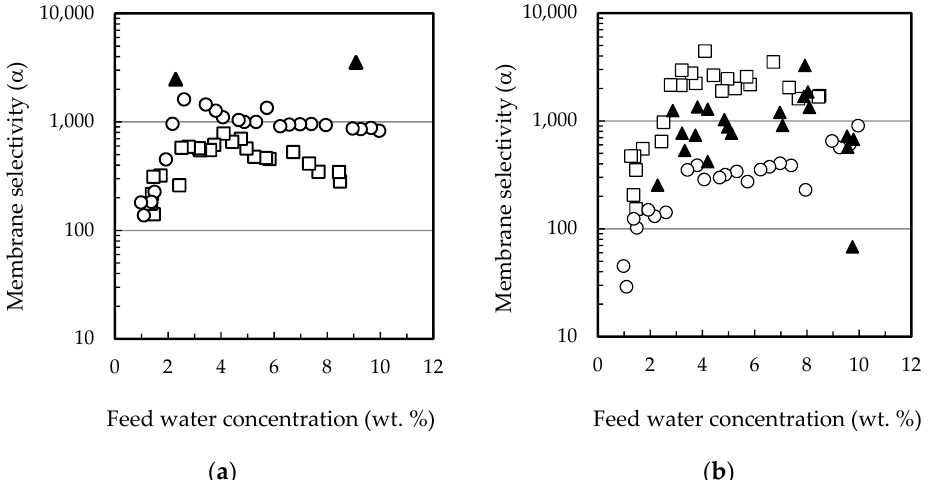
Figure 3. Membrane selectivity as a function of feed water content for the three PV membranes tested ( a ) water/ethanol, ( b ) water/ethyl lactate. ( ) PERVAP TM 3100, ( ) PERVAP TM 1131 ( ) PERVAP TM 2216. Initial feed content: 13.5% lactic acid, 17.7% ethyl lactate, 10% water and 58.8% ethanol. Temperature = 60 °C.